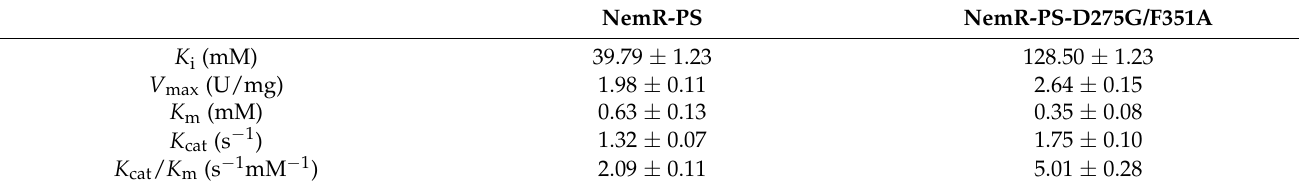
Table 1. Kinetic parameters of the purified NemR-PS and NemR-PS-D275G/F351A 1 .